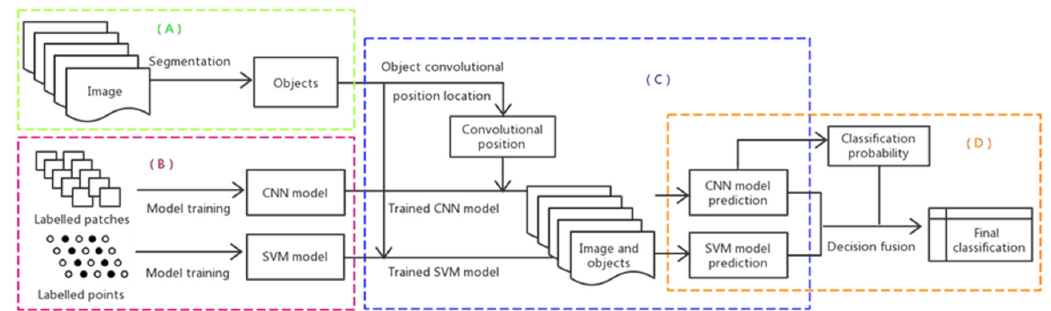
Figure 1. Flowchart illustrating the presented object-based support vector machine-object-based convolutional neural network (OSVM-OCNN) method with four major steps: ( A ) image ( B ) model training, ( C ) model inference and ( D ) fusion segmentation, ( B ) model training, ( C ) model inference and ( D ) fusion decision.